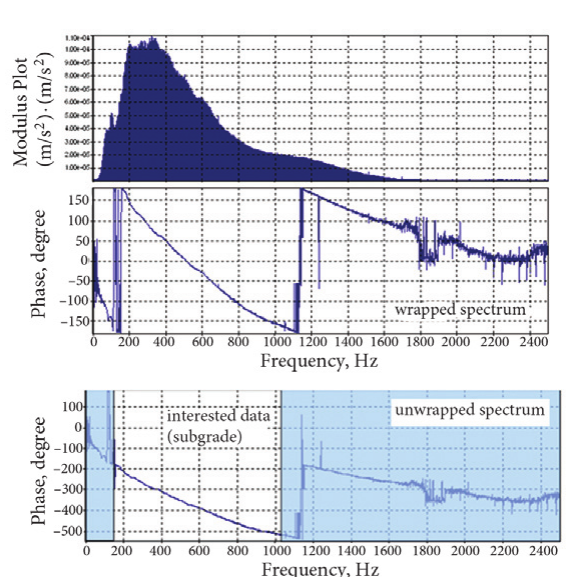
fig. 4. Flow diagram of coupled analysis of the surface wave method